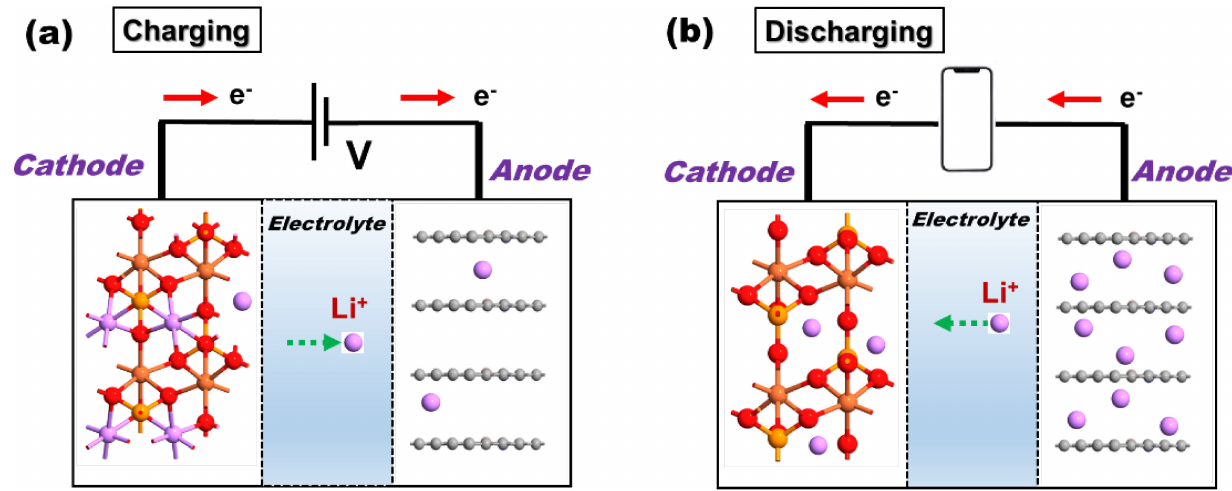
Figure 1. Schematic representation of Li-ion battery ( a ) charging and ( b ) discharging mechanisms. At